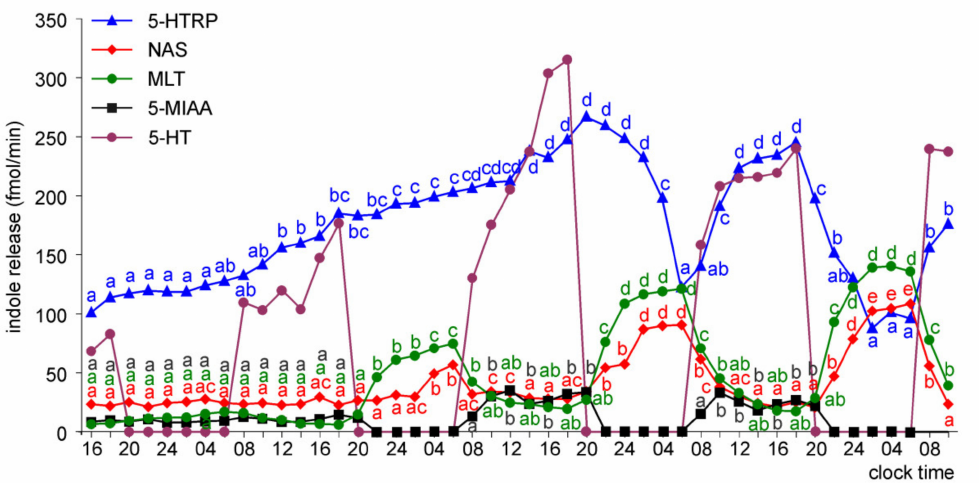
Figure 11. Release of 5-HTRP, NAS, MLT, and 5-MIAA (means, n = 3) from pineal organs of ED 18 embryos incubated under a 12L:12D cycle and treated with NE during photophase. The same letters indicate means, which are not significantly different between